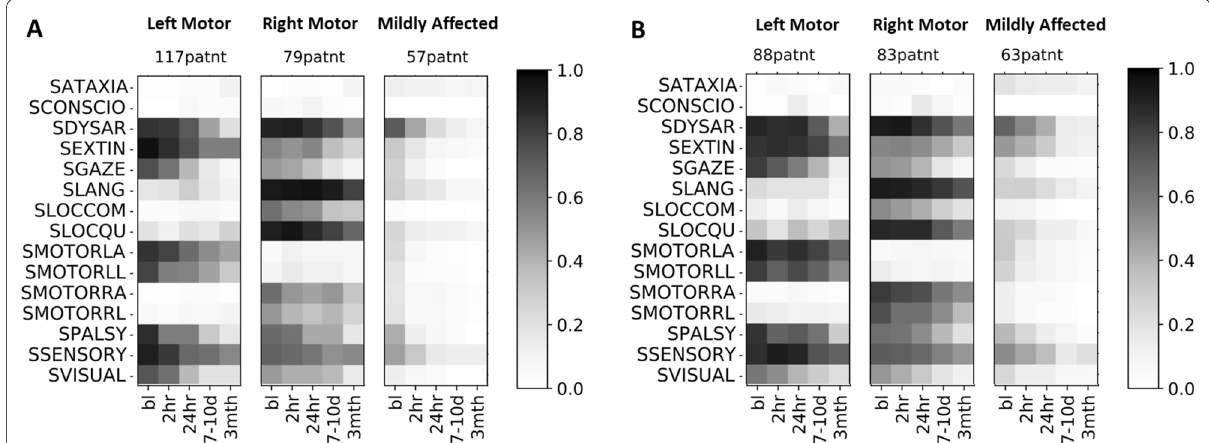
Fig. 4 Trajectory profiles (same as in the above figure) were applied independently on patients that A received tissue plasminogen activator (tPA) treatment within 3 h of stroke onset compared to B patients who received placebo. Subtypes identified by the algorithm containing fewer than 10 patients are not shown (1 outlier patient falls under this category). The shade of grey indicates the affected fraction